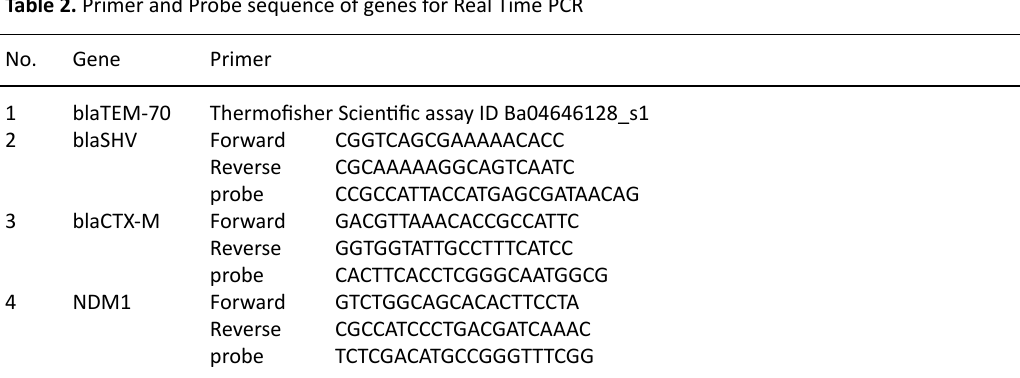
Table 2. Primer and Probe sequence of genes for Real Time PCR